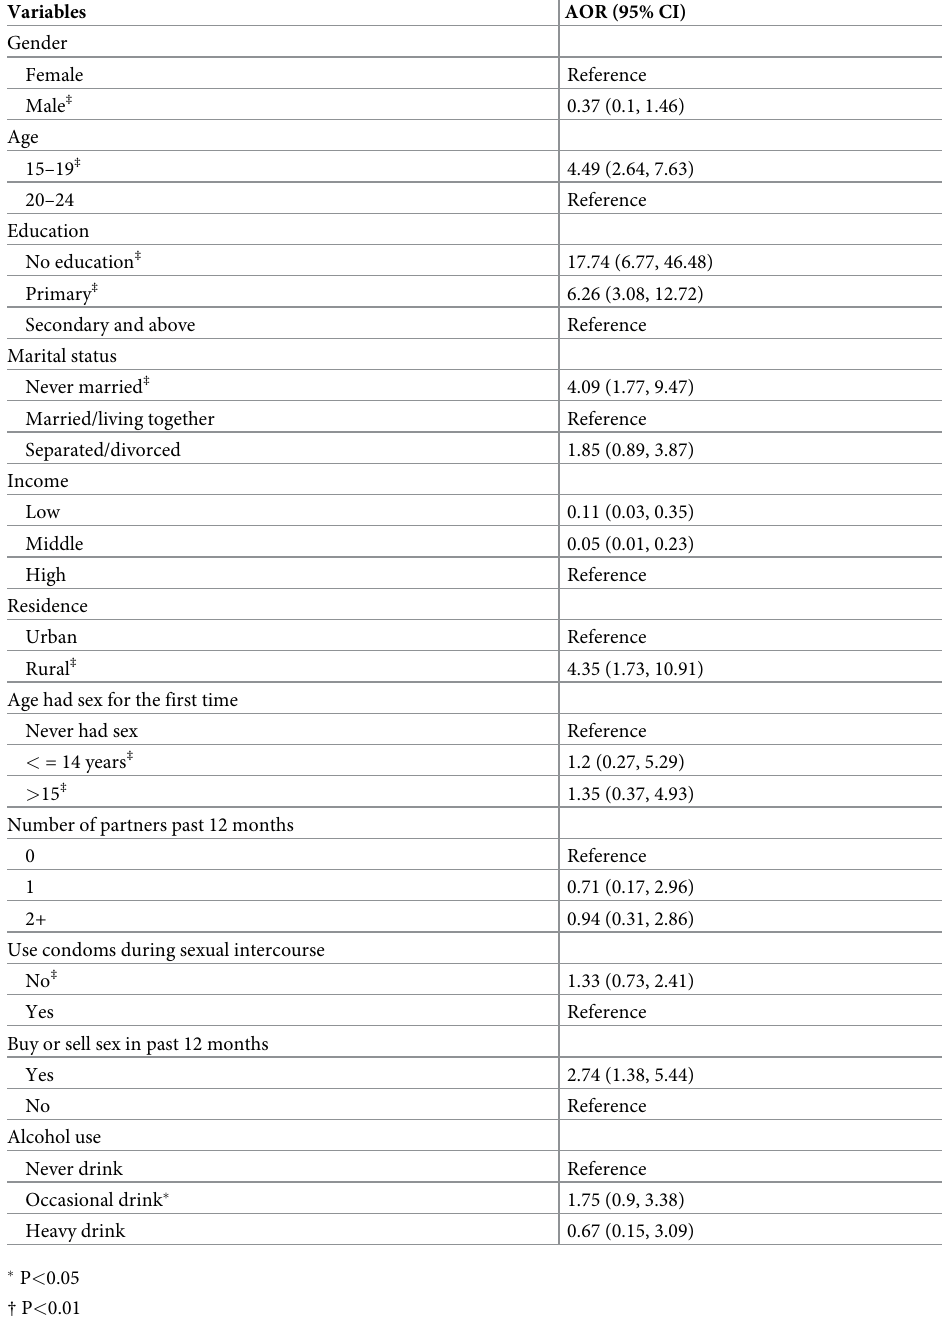
Table 5. Adjusted odds ratio (AOR) for demographic and socio-behavioral characteristics associated with ever having tested for HIV among HIV-infected adolescents and young adults aged 15–24 in Tanzania (N = 0.14